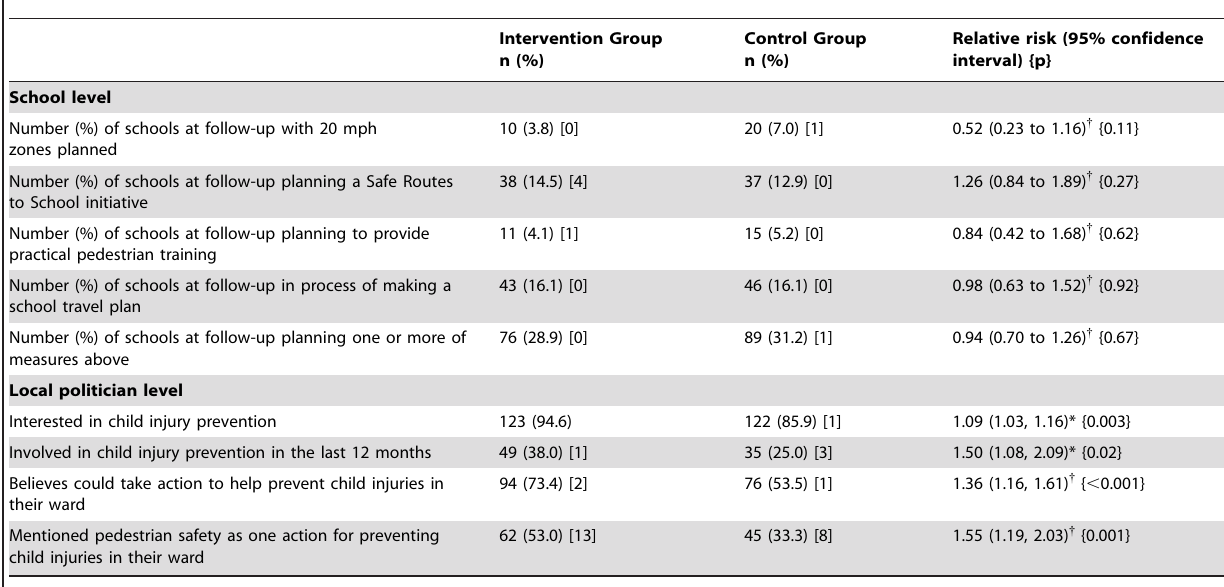
Table 5. Secondary outcome measures by treatment group at 25–30 months post